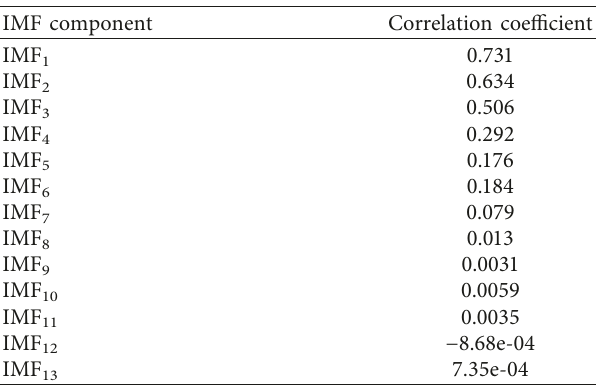
Table 1: Correlation coefficient.